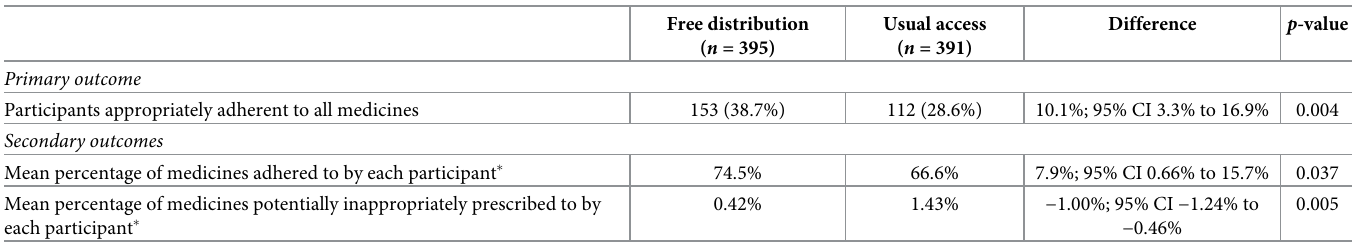
Table 2. Primary and secondary outcomes results by group after 2 years.